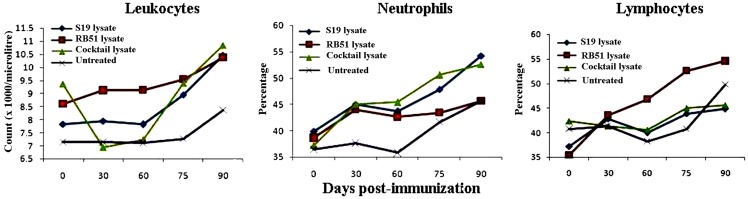
Differential leukocyte counts in immunized and untreated cattle.